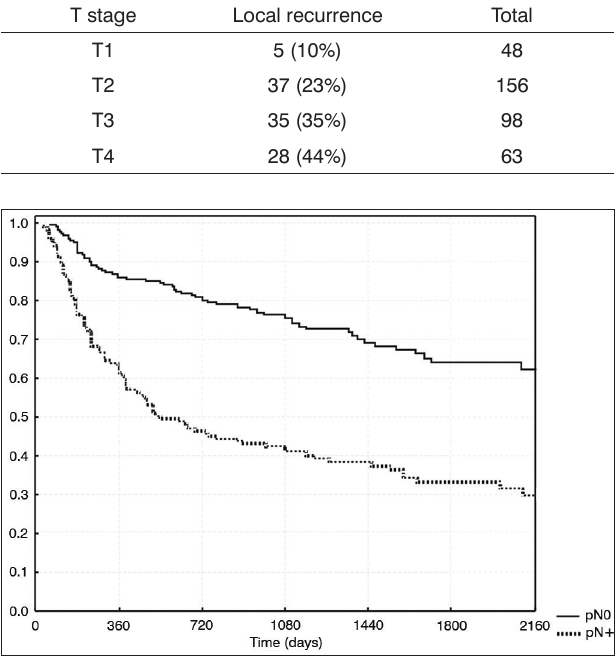
Figure 1. Survival free of disease per pN